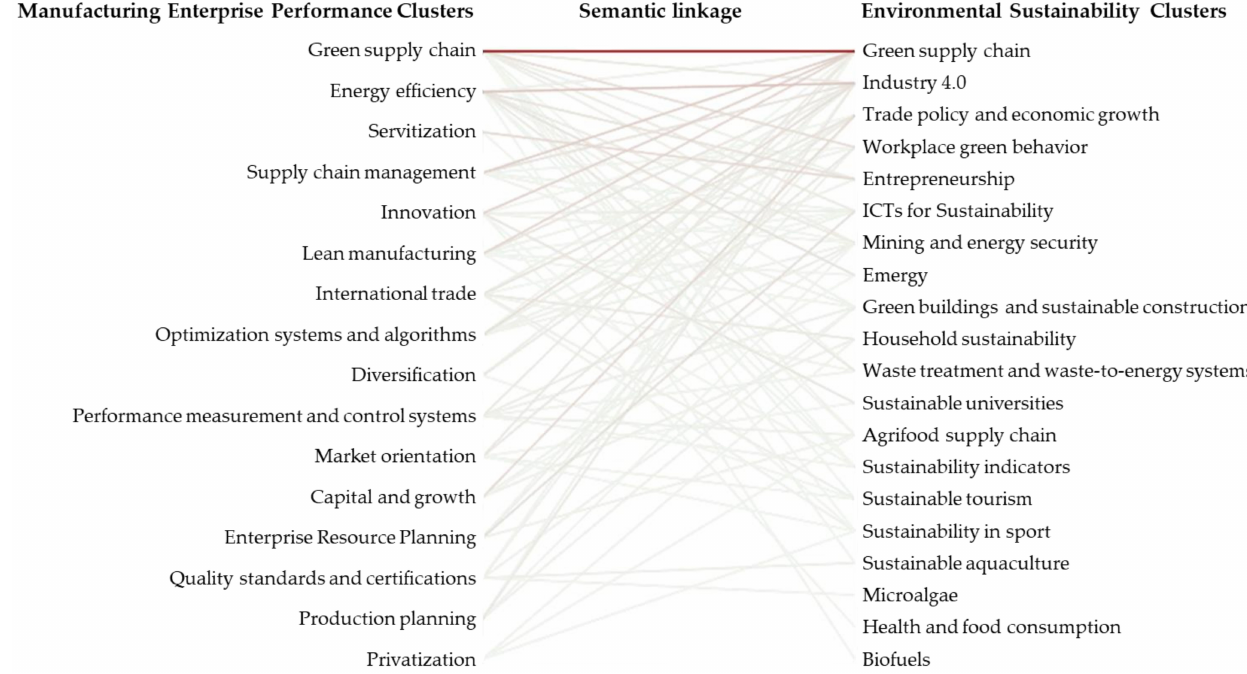
Figure 6. Semantic linkage between MEP and ES. Clusters were sorted from the one most related to clusters in the other network. Those at the bottom are the most distinct